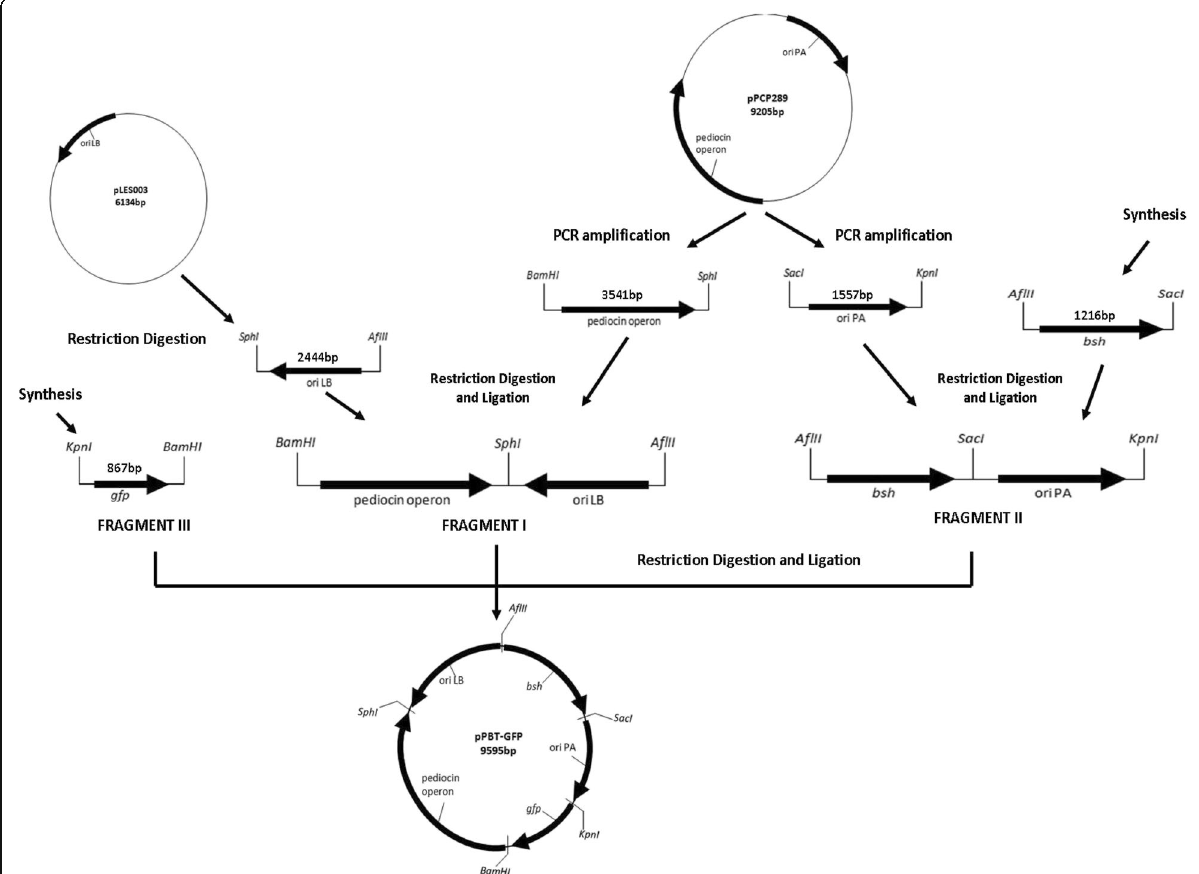
Fig. 2 Schematic representation of the construction of pPBT-GFP